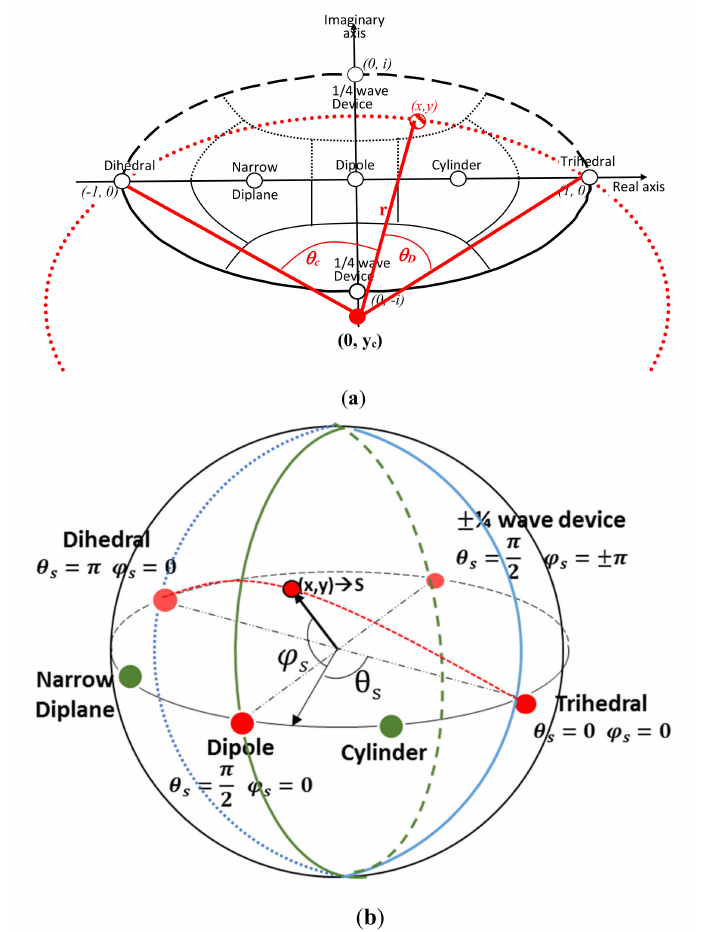
Figure 2. Illustration of mapping of a point (x, y) on the unit disk to the unit sphere as well as the positions taken by the symmetric scattering mechanisms. ( a ) The unit disk from a side view. The diameter of the unit disk containing the elementary scatterers is mapped on the front half of the equator of the unit sphere ( b ). The 1 / 4 Wave Devices are mapped to the back of the equator of the